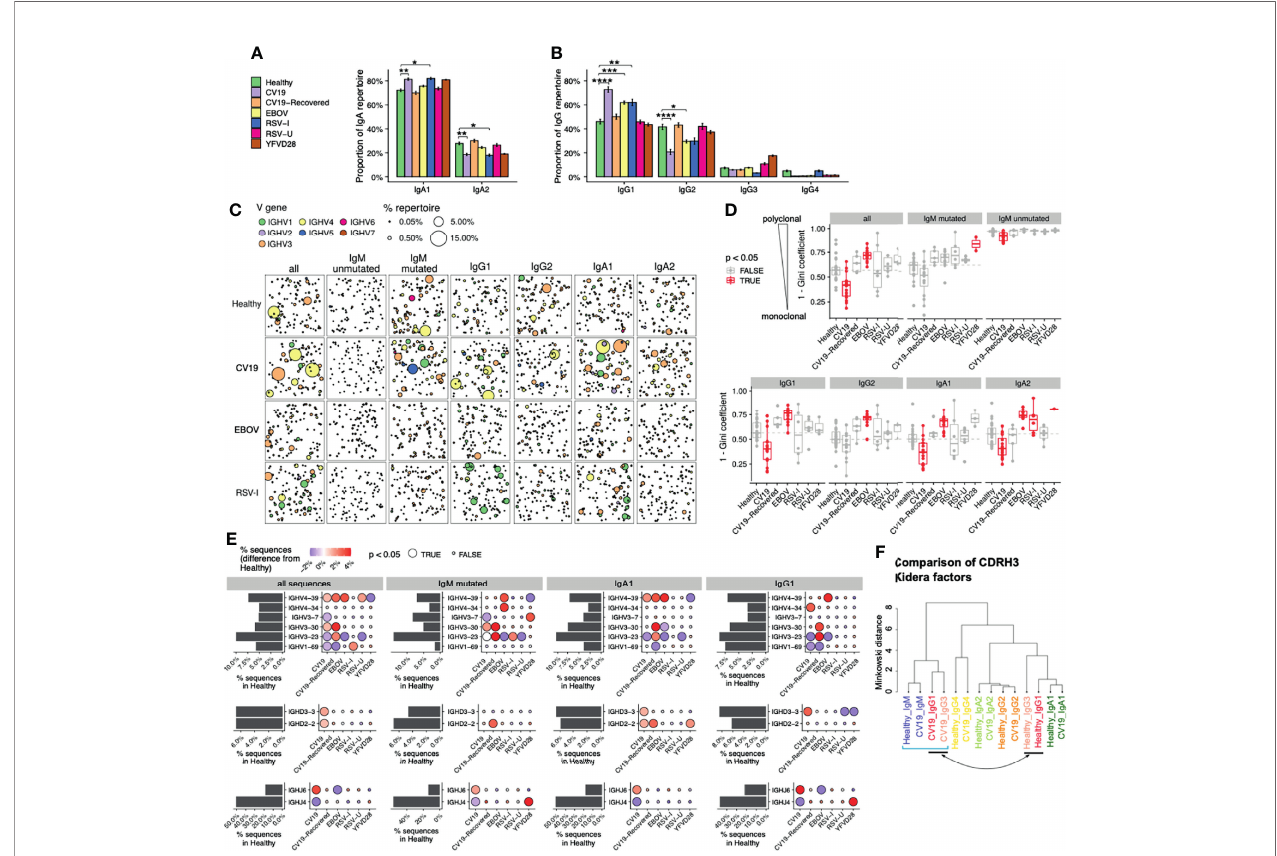
FIGURE 2 | Distinct V-D-J and isotype repertoires in CV19, EBOV and RSV BCR have occasional similarities. (A, B) Difference in sub-class use of IgA (panel a) and IgG (B) in viral disease and healthy BCR repertoires. (C) Clonal expansion of sequences of relevant effector types (as revealed in A) plus unmutated and mutated IgM to identify trends of V gene usage in viral infections. Each bubble sampled to a uniform depth (see Methods), with size proportional to clone size, represents one clone colour-coded by V-family usage. (D) Quanti fi cation of clonal expansion calculated using the Gini coef fi cient (see methods), revealed clonally expanded effector populations (more monoclonal/less diverse, closer to 1) or more diverse clones (closer to 0) in viral infections. Sample types with signi fi cant differences (false discovery rate [FDR] < 0.05) compared against Healthy were highlighted in red. Dashed line indicates the median diversity in the Healthy cohort. (E) Frequency of selected V-D-J gene usage in different cohorts for all sequences and further subdivided by IgM-mutated, IgA1, IgG1. Bar charts depict gene frequency usage in the Healthy cohort. Bubble plots depict the difference in usage (coloured: blue reduced/red increased) compared to healthy repertoires. (F) CDRH3 physicochemical characteristics (represented by Kidera factors) were analysed separated by sub-classes and disease status (Healthy/CV19), and compared using Minkowski distance. Note that IgG1 and IgG3 sequences from CV19 cluster together with IgM (square bracket), away from those of the same sub-classes from healthy individuals (indicated by arrow). Statistical signi fi cance in panels a, d and e was evaluated using one-way ANOVA and Dunnett post-hoc comparison against the Healthy cohort: p-value was corrected using the Benjamini-Hochberg method and expressed as false discovery rate (FDR), indicated either with colour (panel c), bubble size (E) or the symbols under the following scheme: *, FDR < 0.05; **, FDR < 0.01, ***, FDR < 0.001, ****, FDR <